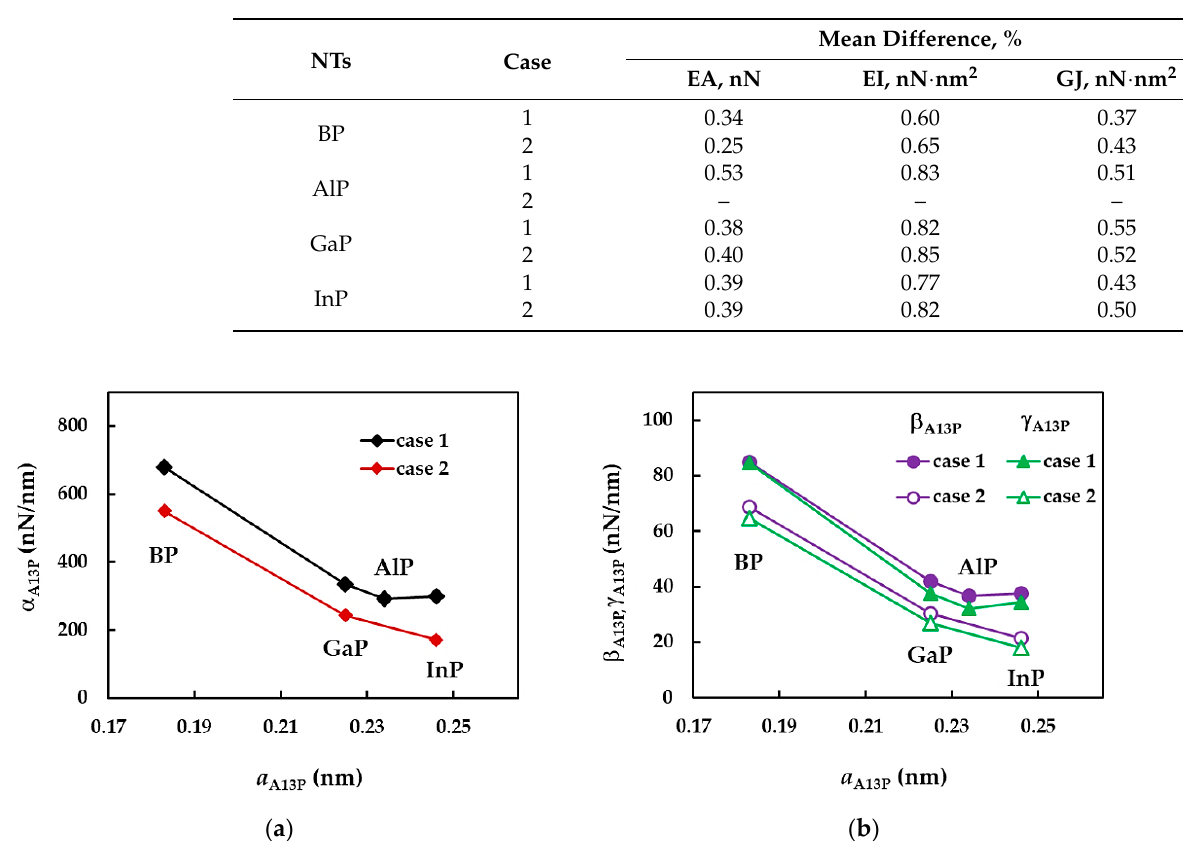
and γ fitting parameters with the bond A13P A13P